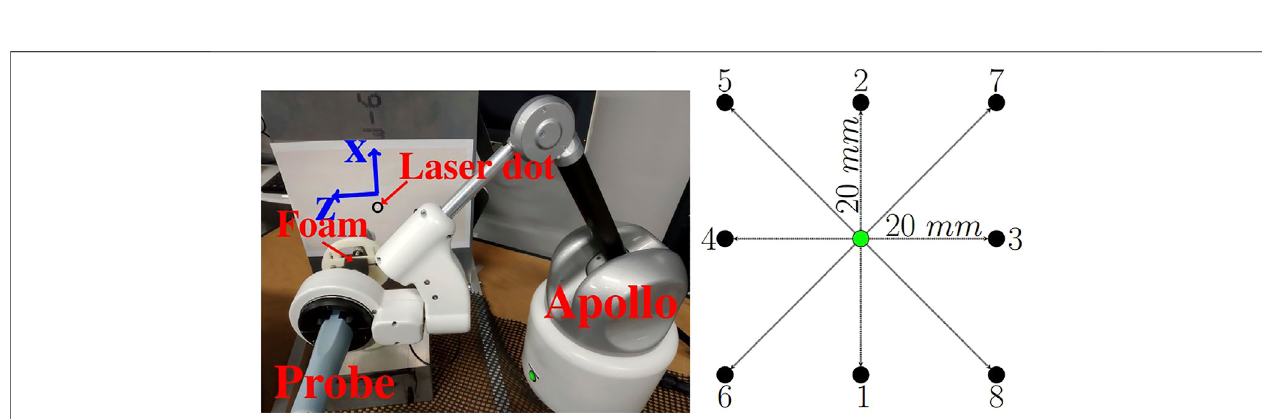
FIGURE 9 | Open loop control of the Apollo robot for automatic fi ne movements of the instrument tip taking into account the elasticity of the environment.